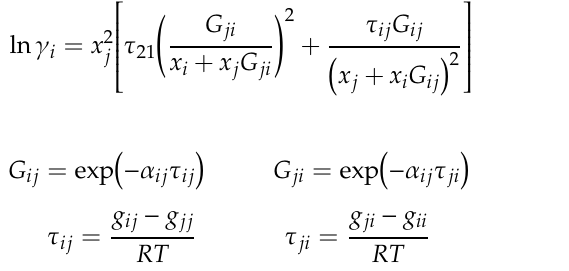
Supplementary Materials: The following are available online, Table S1: The list of chemicals used for synthesis of